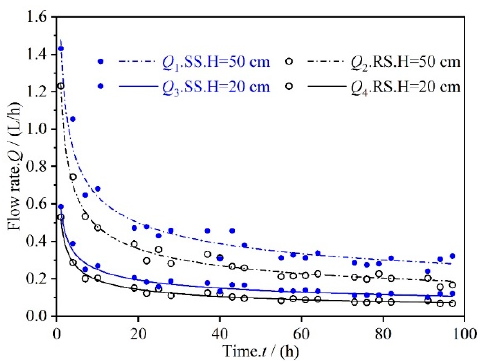
Figure 4. Changes in permeate flux with respect to time for RS and SS series of microporous ceramic filter membranes.